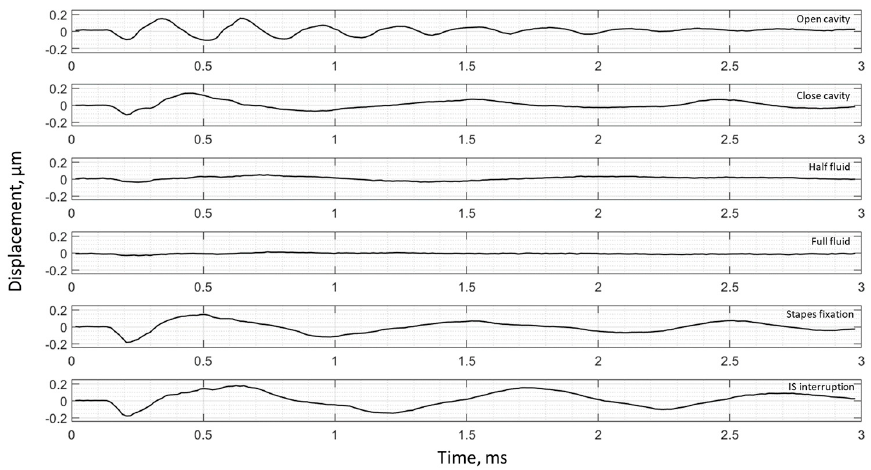
Figure 9. Umbo displacement of TB5 under different cases (umbo location is marked as the intersection of the solid black and dashed black lines in Figure 3c).